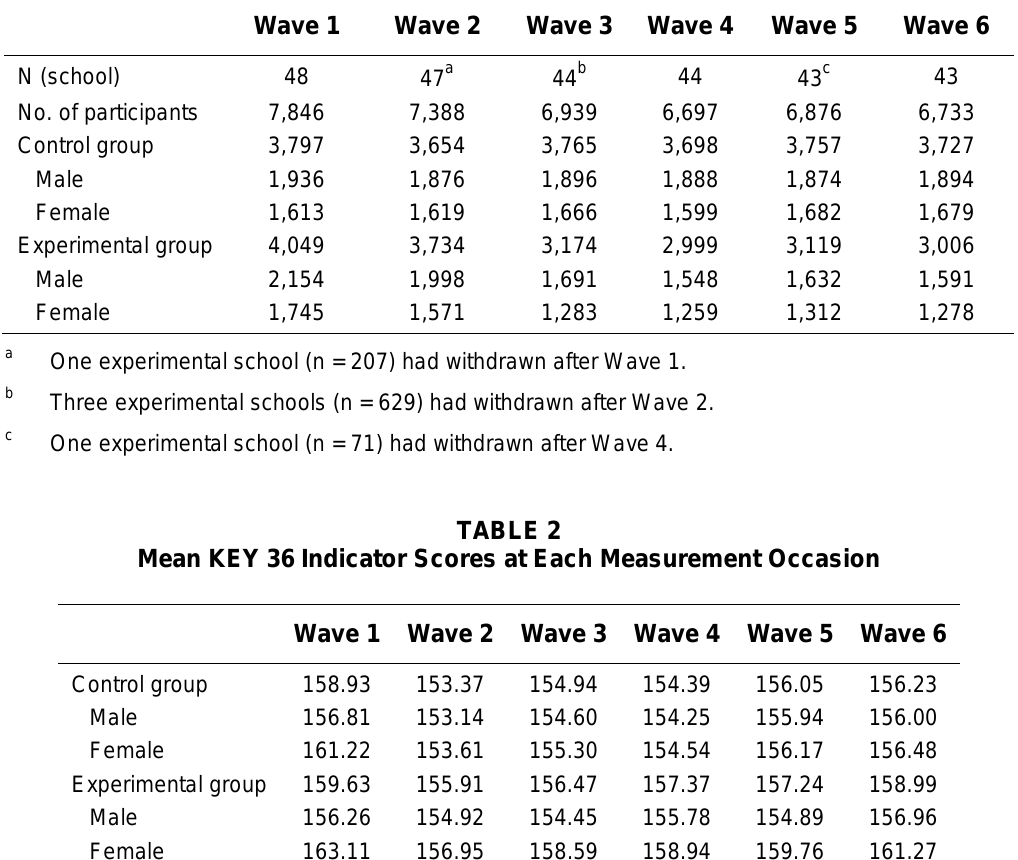
Number of Participants at Each Measurement Occasion